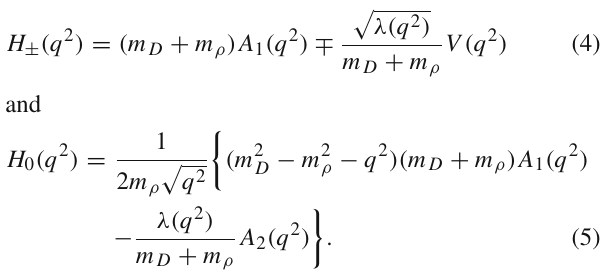
decay widths of D → ρ e + ν e can be expressed in terms of three helicity amplitudes H 0 , ± ( q 2 ) : | K | 2 G 2 HV F (cid:5) a = = ( m − m ρ ) 2 , and λ( q 2 ) is where a = + , − , 0, q 2 D max + m 2 − q 2 ) 2 − the phase-space factor, which equals to ( m 2 ρ D m 2 ρ . The Fermi constant G F = 1 . 166 × 10 − 5 GeV − 2 . 4 m 2 D The constant K HV parameterizes the quark flavor mixing relevant to a particular transition, which equals to | V cd | for total decay width of D + / 0 → ρ 0 / − e + ν e can be written as